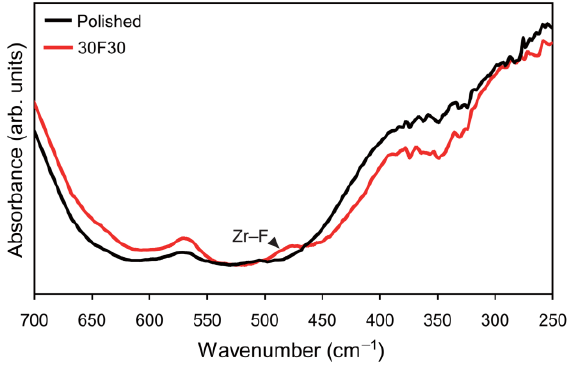
Figure 6. Far-infrared (FIR) spectra of zirconia polished and etched with 30% HF for 30 min